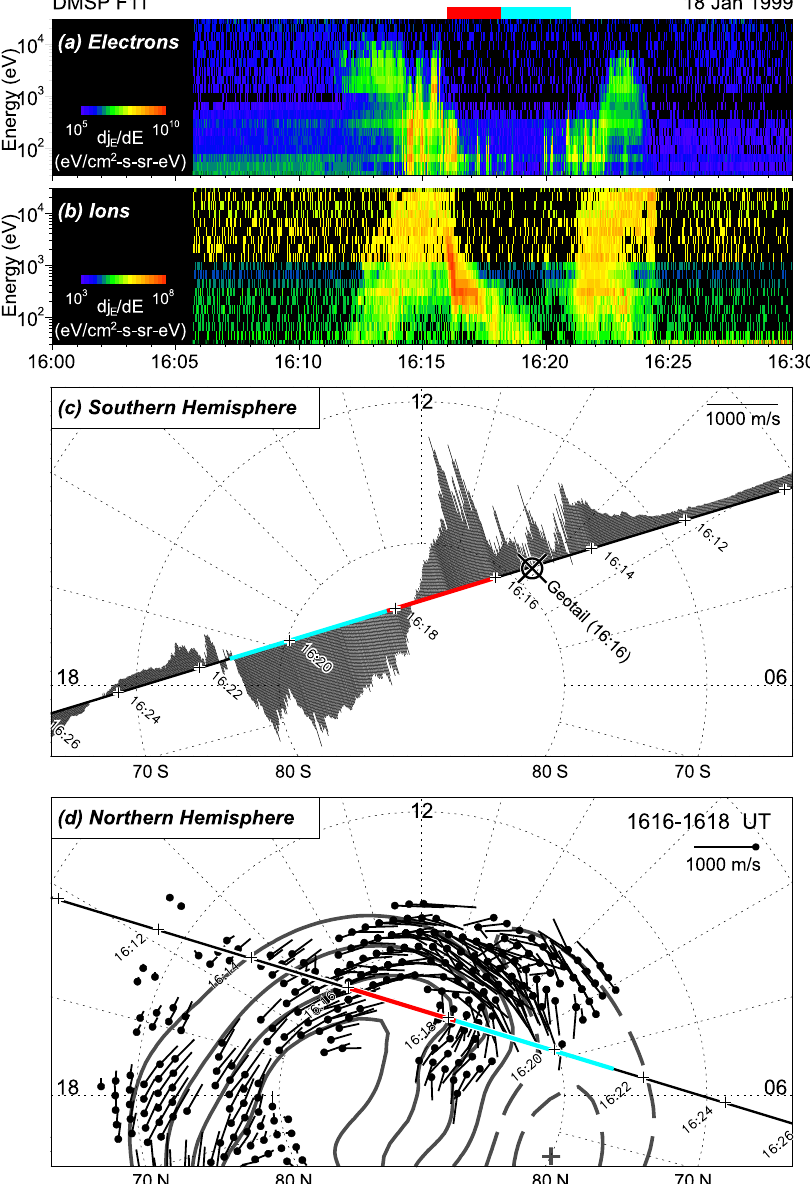
Fig. 11. DMSP F11 (a) electron and (b) ion spectrograms measured between 16:00 and 16:30 UT as the spacecraft traversed the southern dayside auroral zone. (c) The horizontal drift measured during the DMSP crossing of the Southern Hemisphere, overlaid with the approximate footprint of Geotail at 16:16 UT, when it measured an FTE at the magnetopause. (d) The Northern Hemisphere convection velocities (vectors and velocity streamlines) deduced from all northern hemisphere SuperDARN radars, overlaid with the DMSP track, which has been reflected across magnetic local noon. The red and blue lines above the top panel signify times when cusp/mantle precipitation and virtually no precipitation was measured, respectively, and these correspond to the coloured sections of the satellite trajectory in the lower two